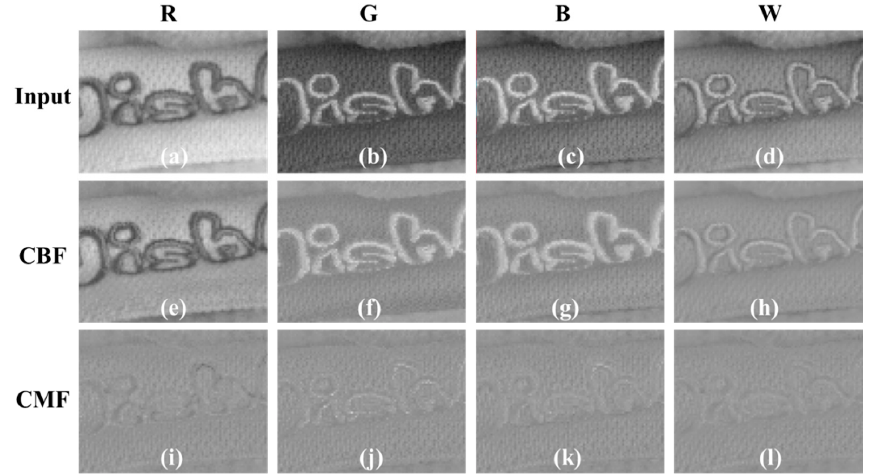
Figure 9. Comparison of texture components decomposed through cross bilateral filter (CBF) and cross multilateral filter (CMF): ( a – d ) Original image; ( e – h ) texture components of CBF results; ( i – l ) texture components of CMF results.